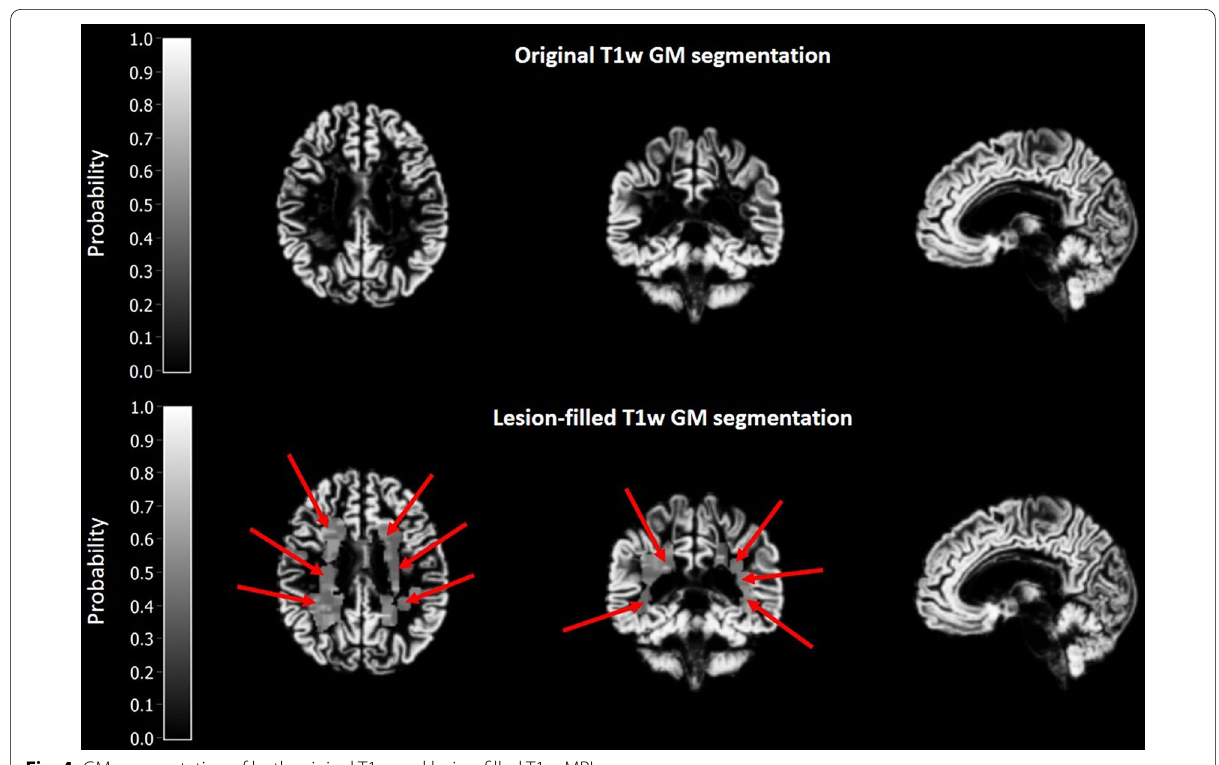
Fig. 4 GM segmentation of both original T1w and lesion‑filled T1w